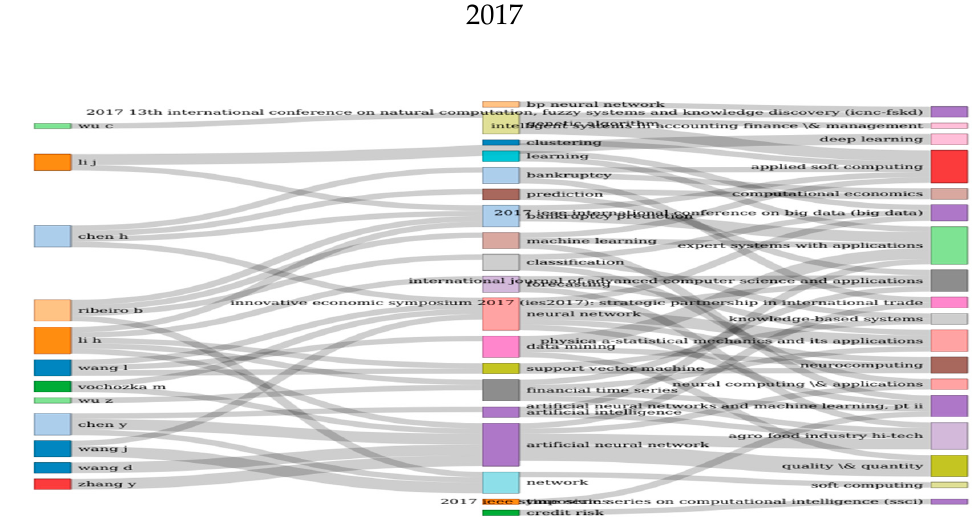
Figure 16. Three fields plot, overall period and per year.